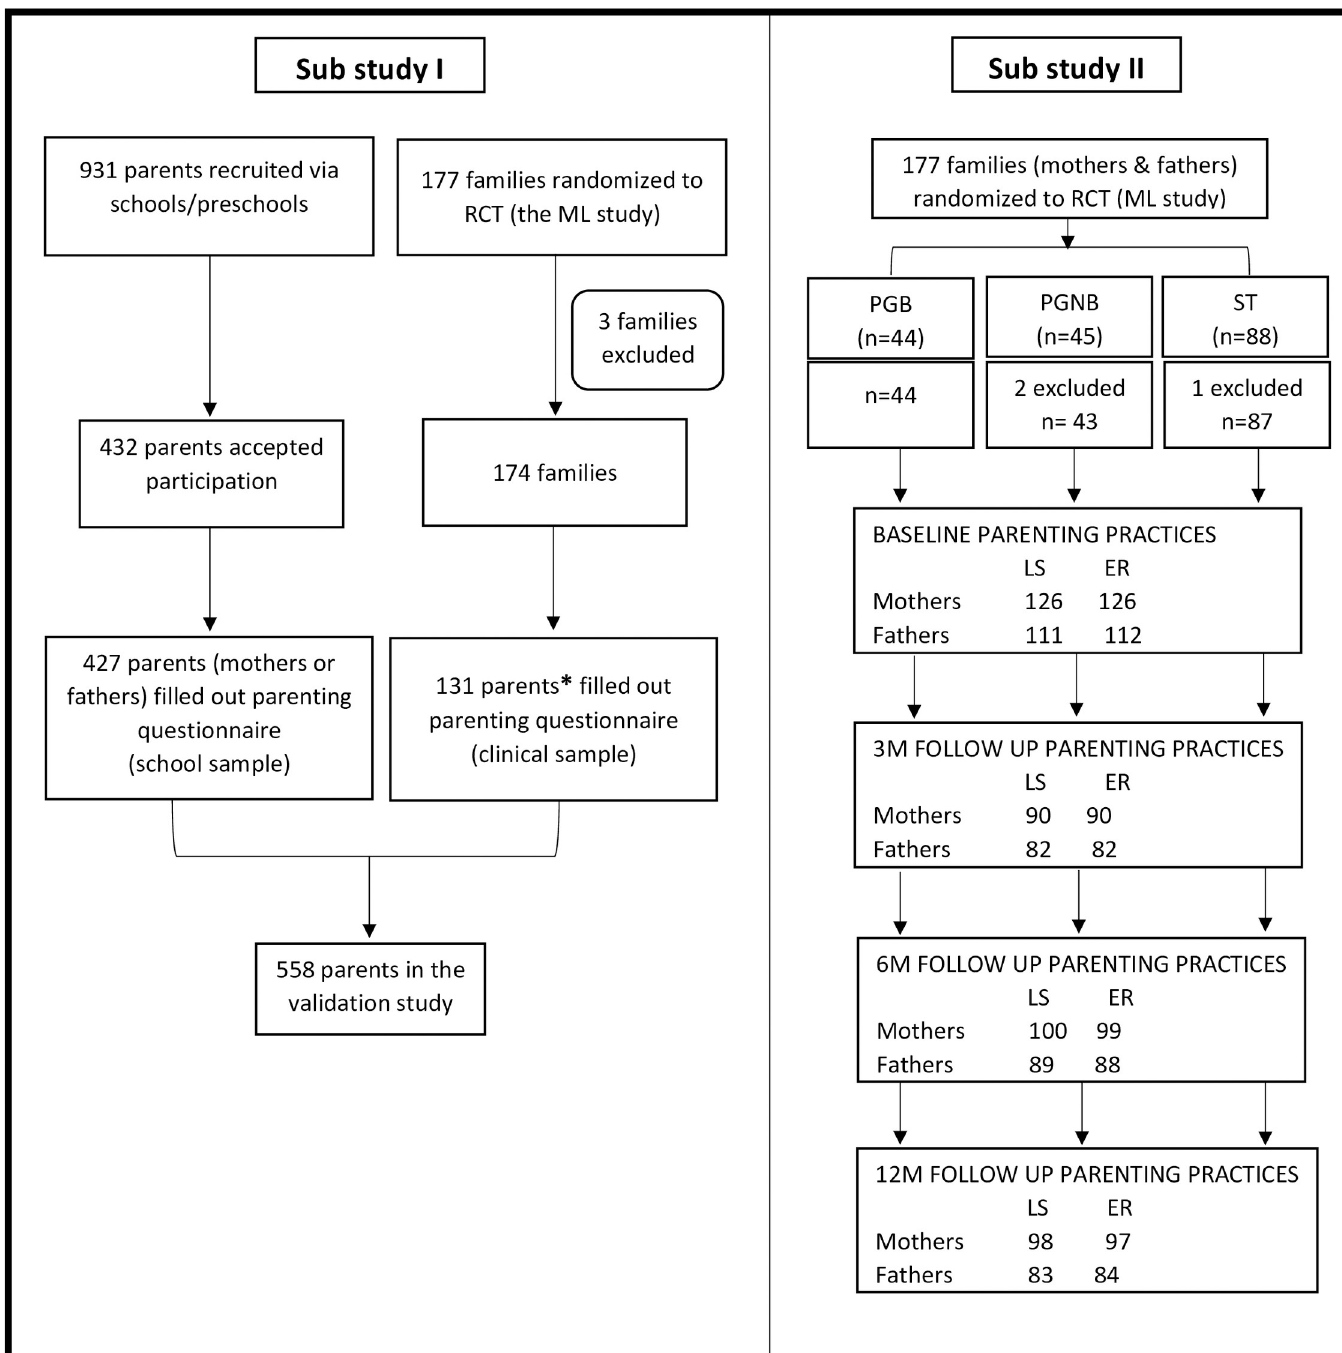
Fig 1. The samples analyzed in the paper. Left side: The two sub samples in the validation study (study I). Right side: sample in the ML study/ RCT with three treatment conditions (study II). � In study I, baseline data on parenting practices from the ML study were included. Only one parent’s report on parenting was used in the validation study, this parent had also filled out a questionnaire about child eating behavior. The latter could have been filled out by one parent/caregiver only.